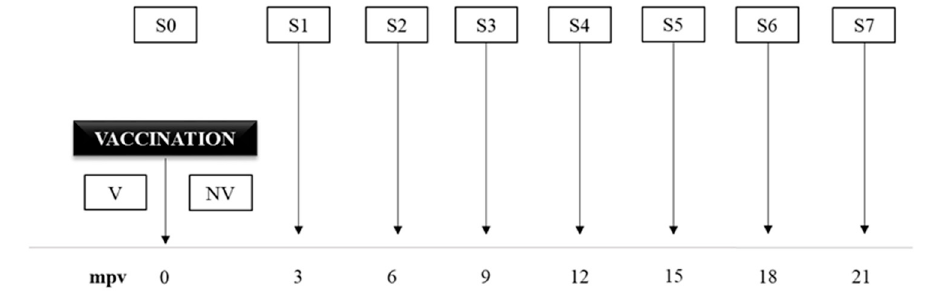
Figure 1. Schedule of the study design and blood sampling times (S0 to S7). S: sampling; mpv: months post vaccination. V: vaccinated; NV: non ‐ vaccinated.